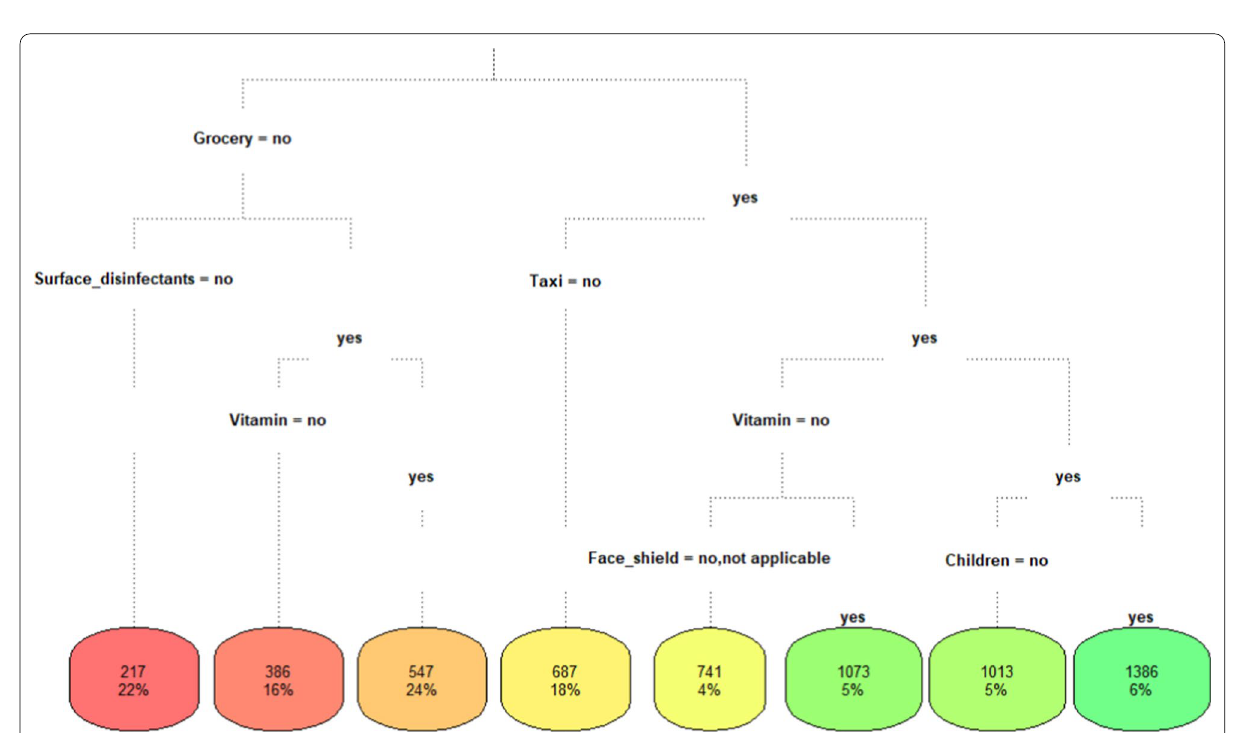
Fig. 2 Regression tree modelling for predicting the total average extra costs per